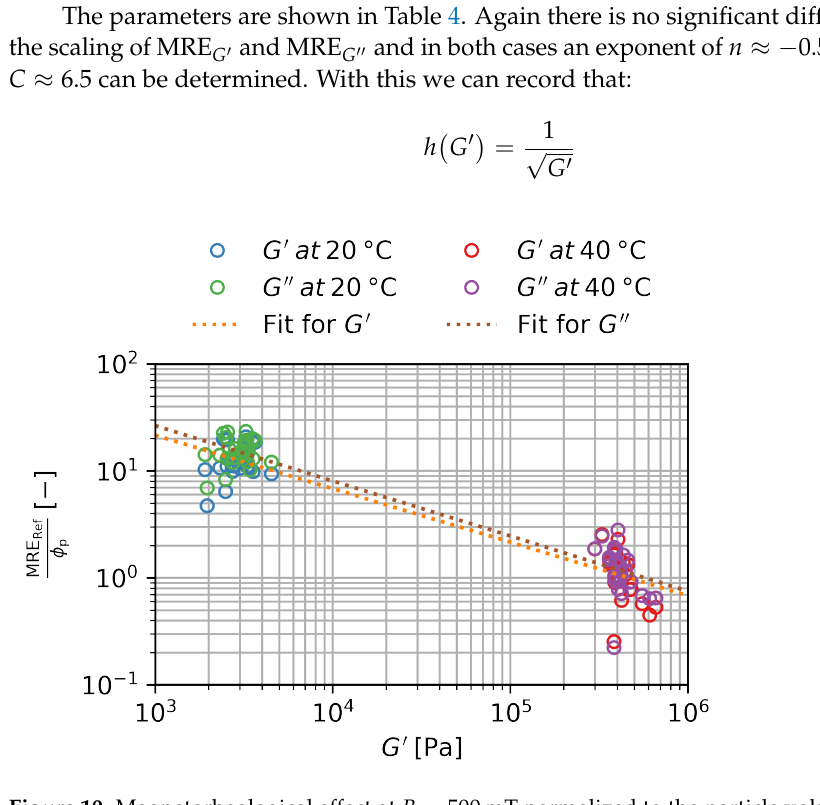
Figure 10. Magnetorheological effect at B = 500mT normalized to the particle volume fraction over the storage modulus for the storage and loss modulus in the swollen and deswollen state. Three samples per w s are shown. Error bars are smaller than the symbols. Table 4. Fit parameters for Equation (10) for the data shown in Figure